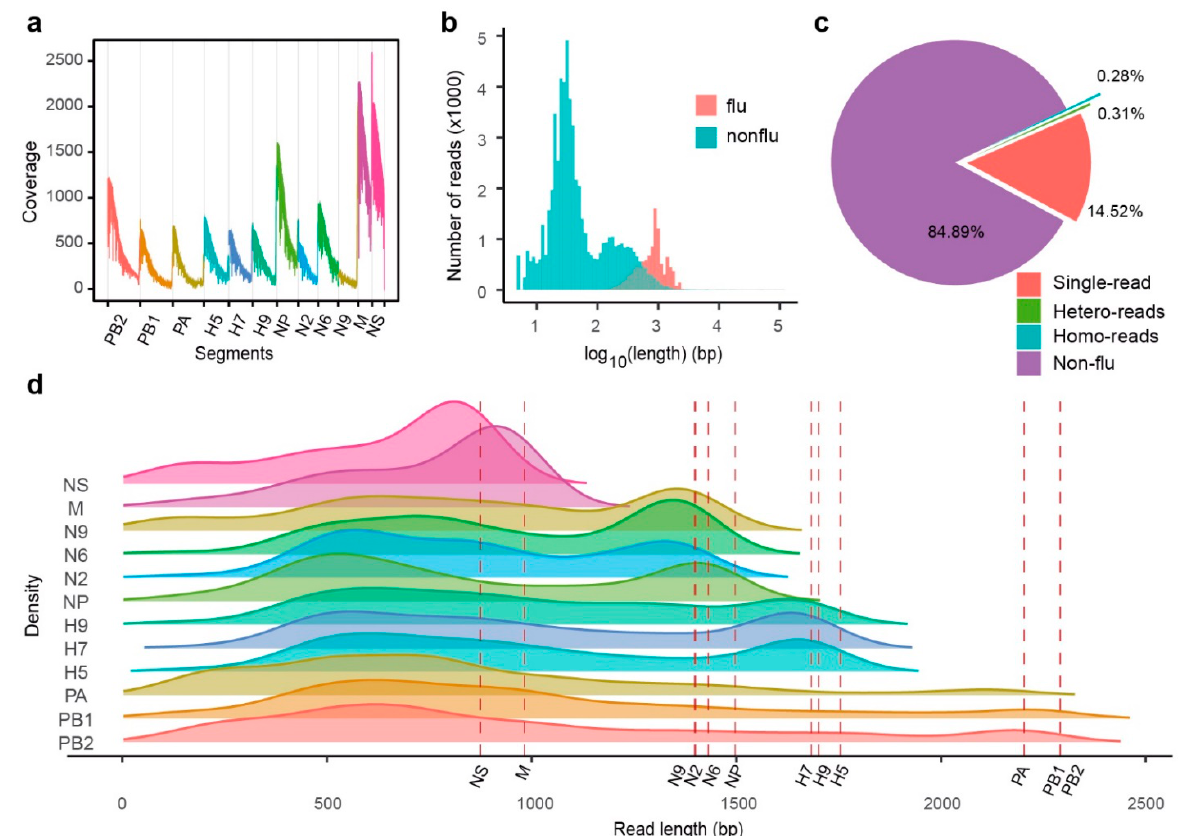
Figure 2. Statistics of direct RNA sequencing reads of MinION platform for influenza A virus sample. ( a ) Coverage of MinION direct RNA sequencing reads to Illumina consensus sequences. ( b ) Raw reads length distribution of MinION direct RNA sequencing reads, the flu reads (red) and the nonflu reads (blue). ( c ) Proportion of different kind of reads. Single-read was a raw read, containing only one segment. Hetero-reads were consisting of two different segments. Homo-reads were reads consisting of two same segments. Nonflu reads were not flu virus reads. ( d ) Density plot for length of each separated segment. The red dashed-lines depicted the length of each related segments, respectively.